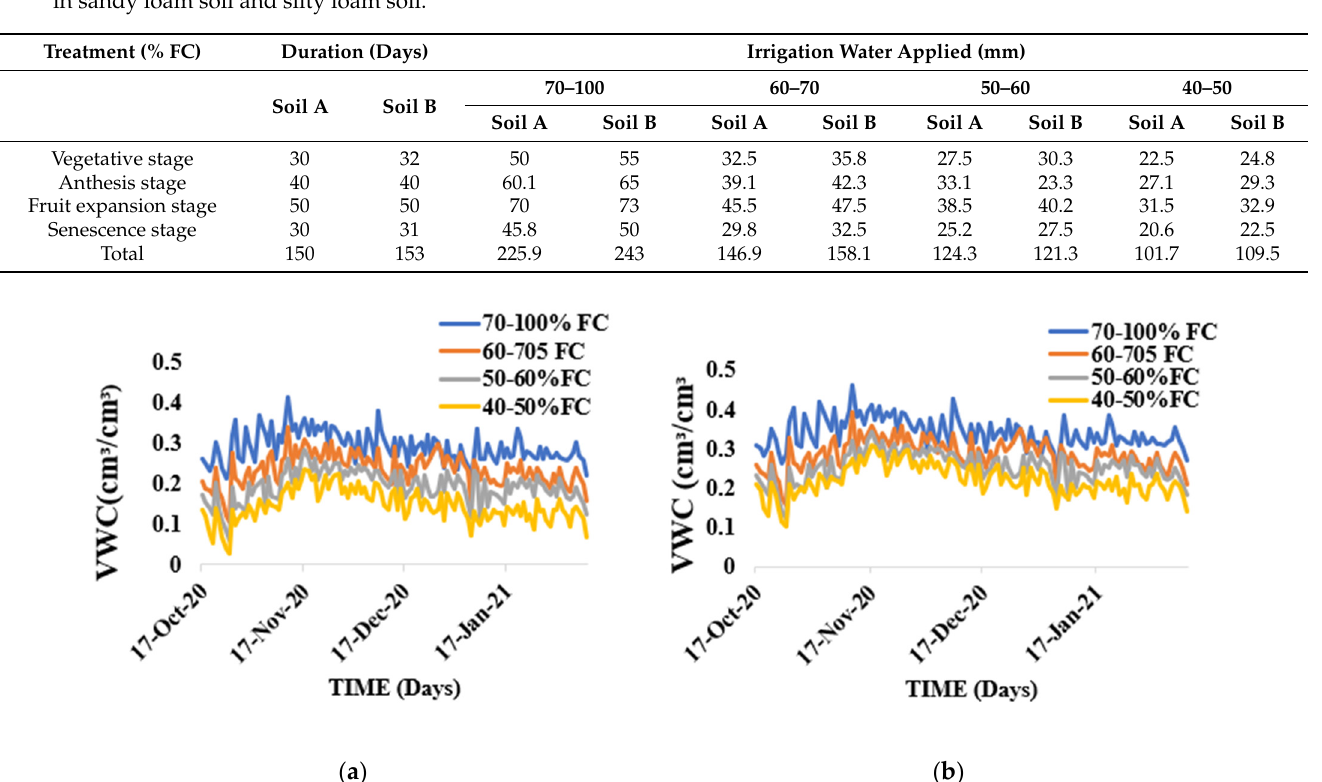
Figure 1. Difference in moisture content determination by volume and TDR ( ± 5%) for ( a ) sandy loam soil and ( b ) silty loam soil. Table 3. Irrigation water applied to tomatoes throughout the growing cycle for each growth stage for the different treatments in sandy loam soil and silty loam soil.